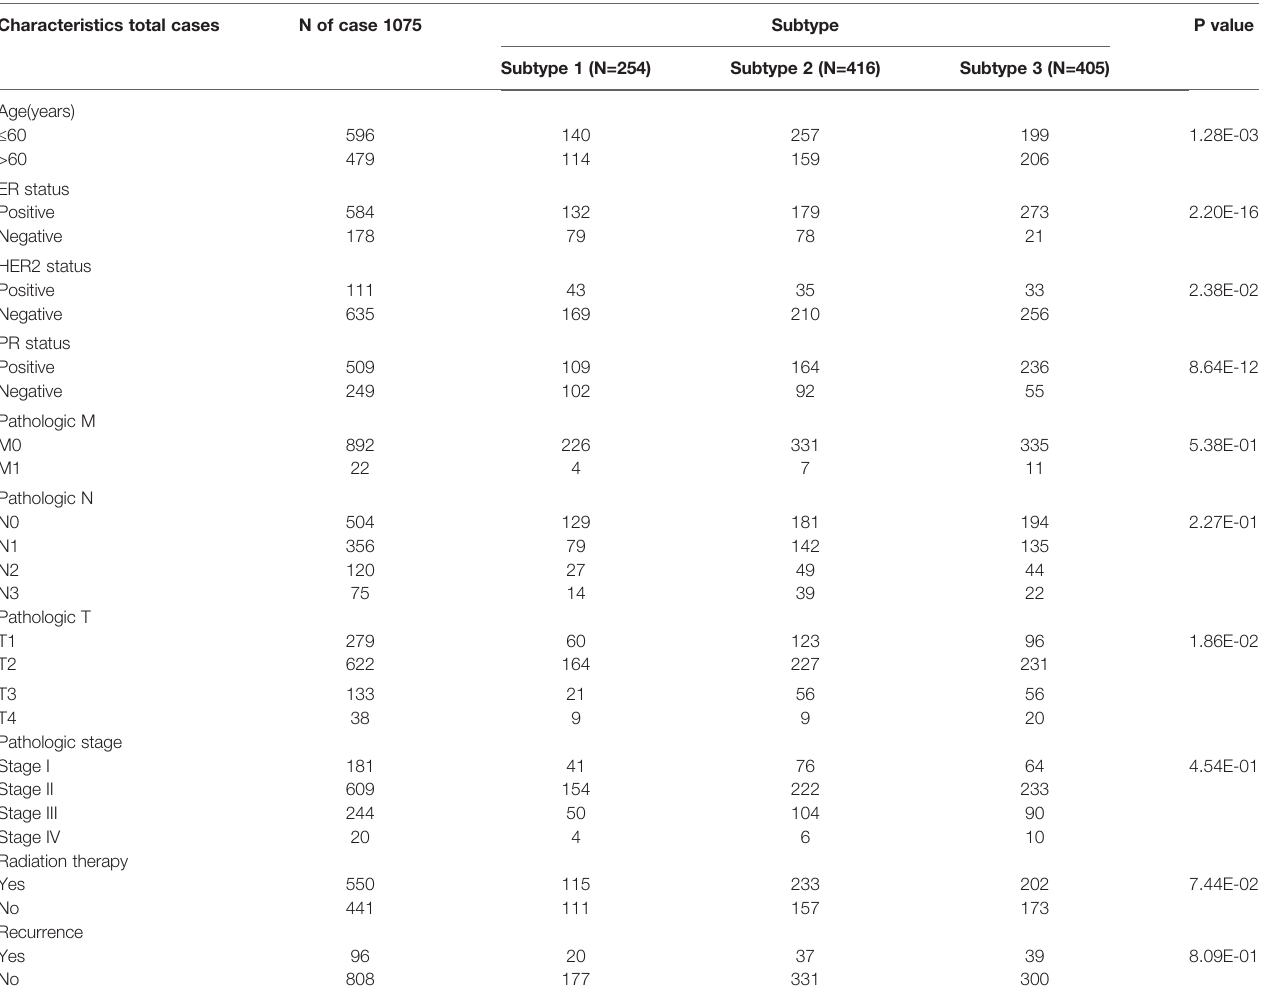
TABLE 1 | Distribution of clinical information among different subtypes. Characteristics total